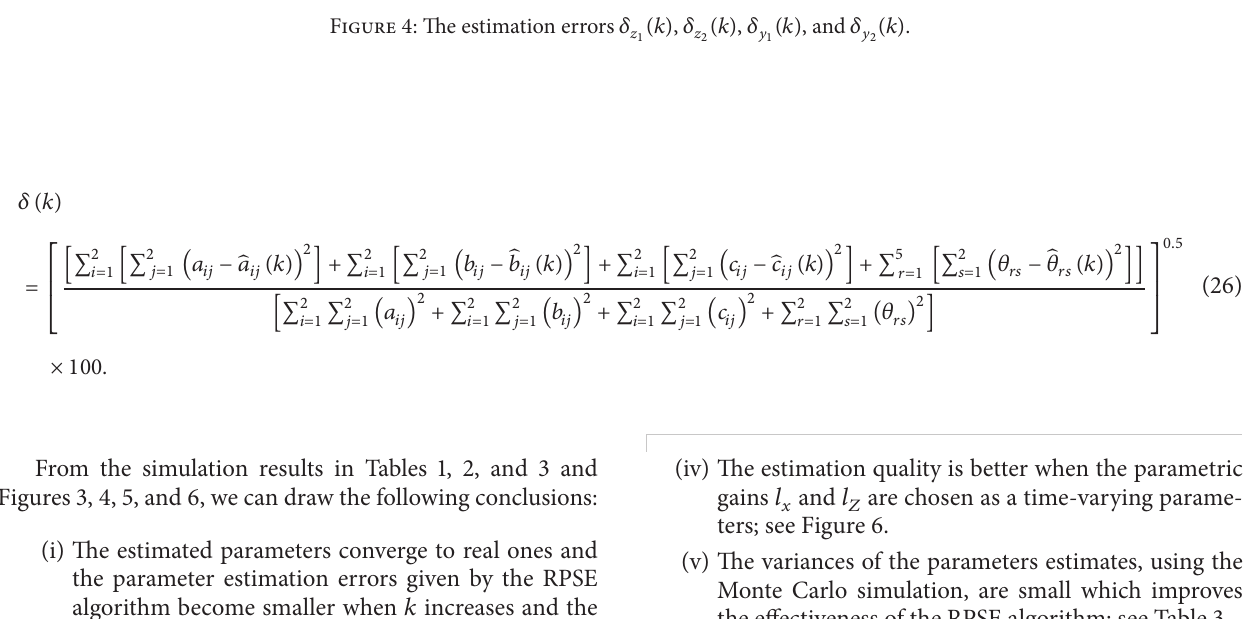
Figure 4: The estimation errors 𝛿 𝑧